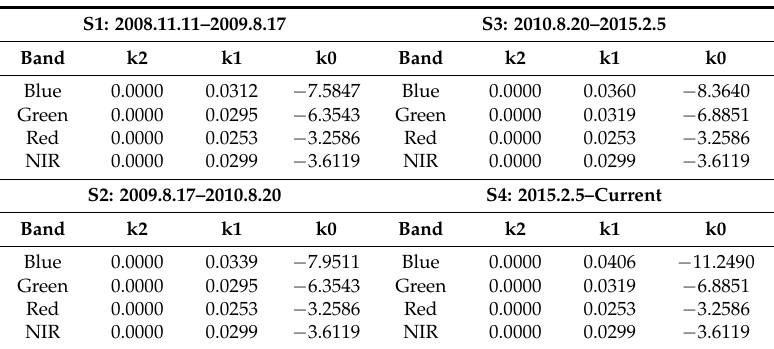
Table 3. The calibration coefficients of FY-3A/MERSI.